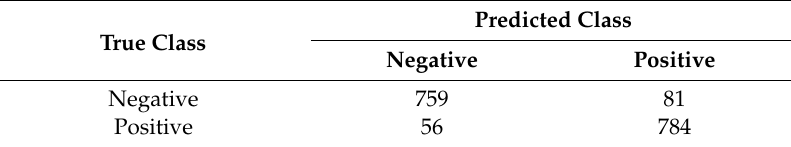
Table 11. Deep FC2 features and NB classifier.